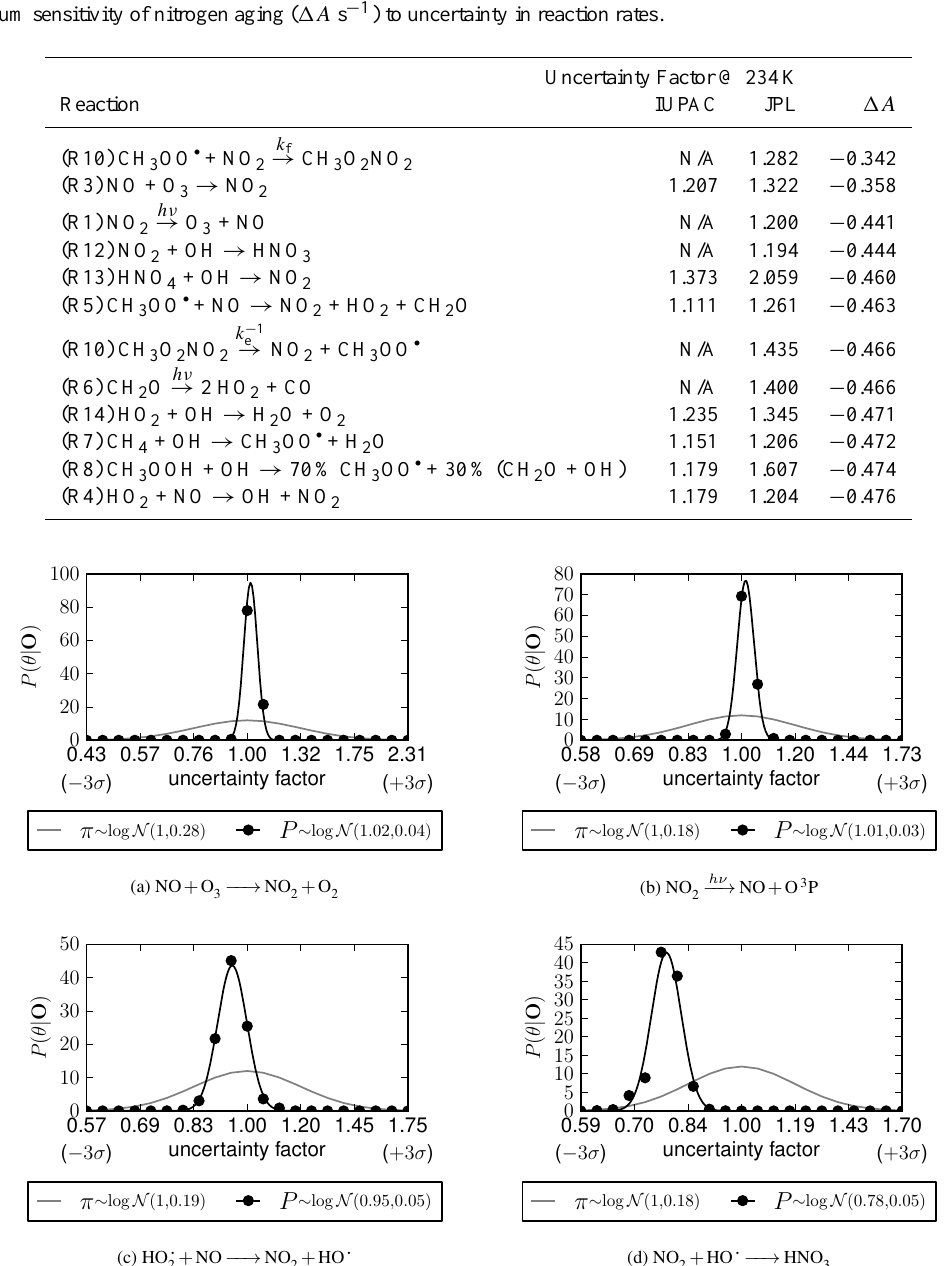
Fig. 4. Posterior (black) and prior (gray) uncertainty distributions of selected reactions. Posterior distributions are explicitly calculated at 21 points shown by black squares, and the smoothed line is fit from the mean and standard deviation. The estimate and standard deviation have both been substantially revised for the production of HNO HNO production, Fig. 4d shows that the revised rate coefficient is 22% lower (within 1 σ ) than the base rate 3 from JPL06 and the standard deviation has been reduced by 62%. Based on the log-normal uncertainty, the 95% credible interval for the revised rate is 66-85% of the base rate.